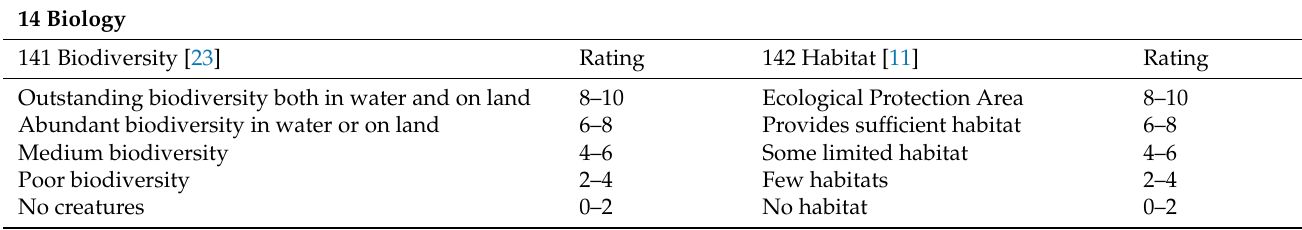
Table 9. Rating for elements of biology layer in ecological